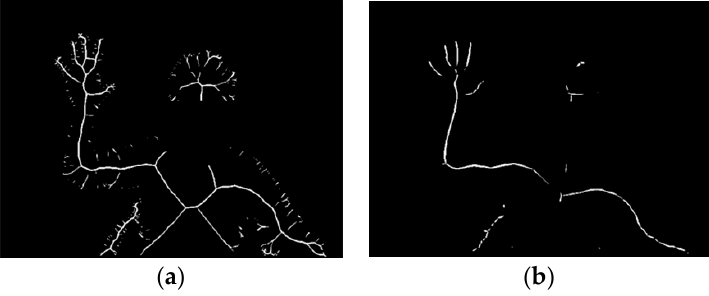
Figure 5. The process to highlight the outline of a skeleton frame: ( a ) before Gaussian 7 × 7 smoothing and ( b ) after Gaussian 7 × 7 smoothing.